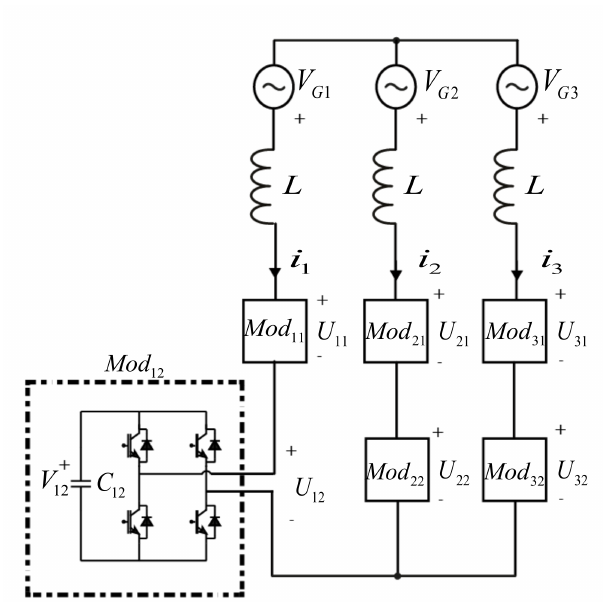
Figure 1. Schematic of the CHB topology. The figure also shows the nomenclature considered in this paper, including the sign criteria and the ordering of the